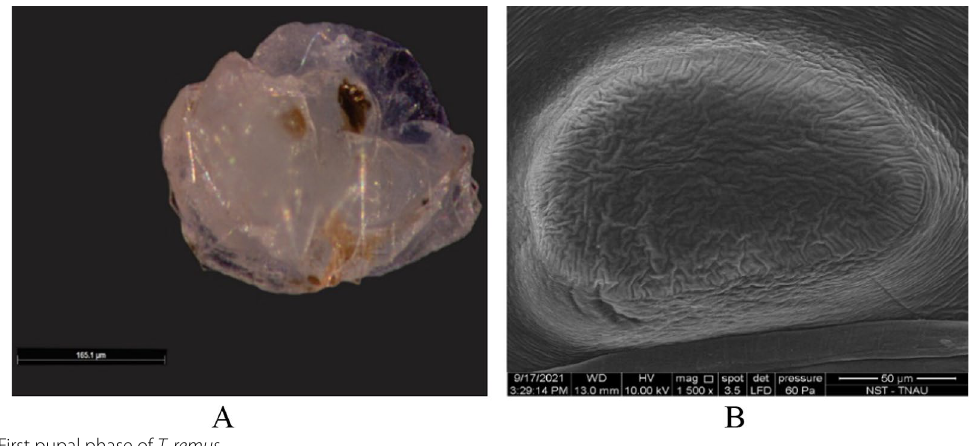
Fig. 7 A, B First pupal phase of T. remus